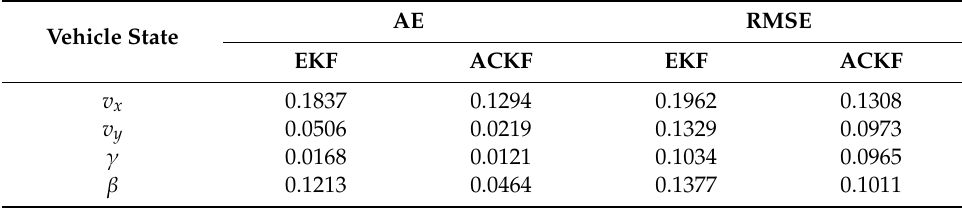
Table 2. Quantitative analysis of estimation effects in double lane changes maneuver.